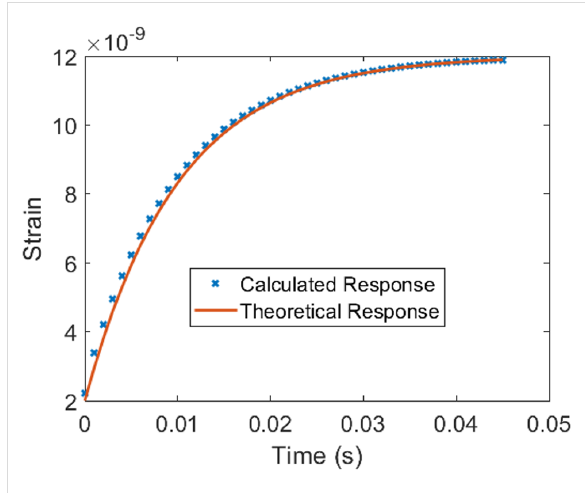
Figure 10: Material response to a step input calculated from the retar- dance obtained through the previously simulated force–distance exper- iment (with a ramp force input), and comparison with the theoretical